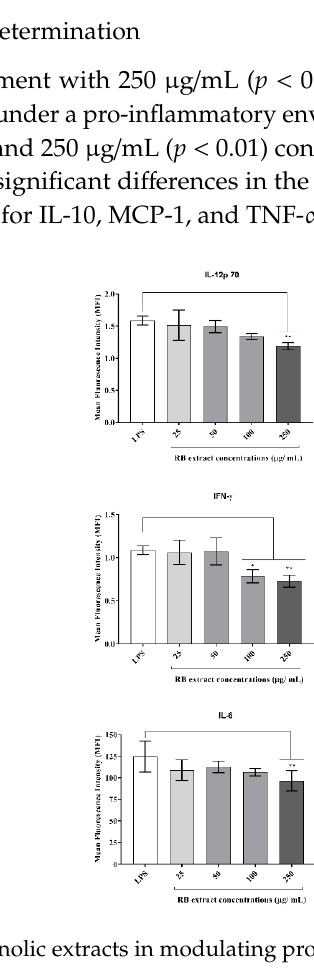
Figure 4. Effect of RB phenolic extract on nitric oxide levels in RAW264.7 cells induced with LPS. A significant reduction in the nitric oxide levels is observed after treatment with the different concentrations (25 – 250 µg/mL) of RB phenolic extracts compared to the control ( n = 5). The level of significance is indicated by the asterisks, whereby ** p < 0.01, *** p < 0.001, **** p < 0.0001. Data are presented as mean ± SD. Lipopolysaccharide, LPS; rice bran, RB.